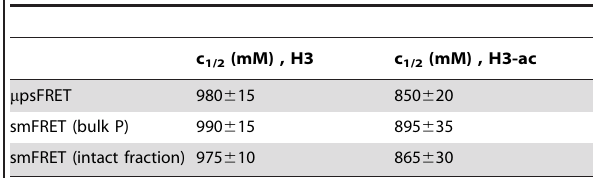
Table 1. Comparison of c 1/2 – values from m psFRET and smFRET experiments.